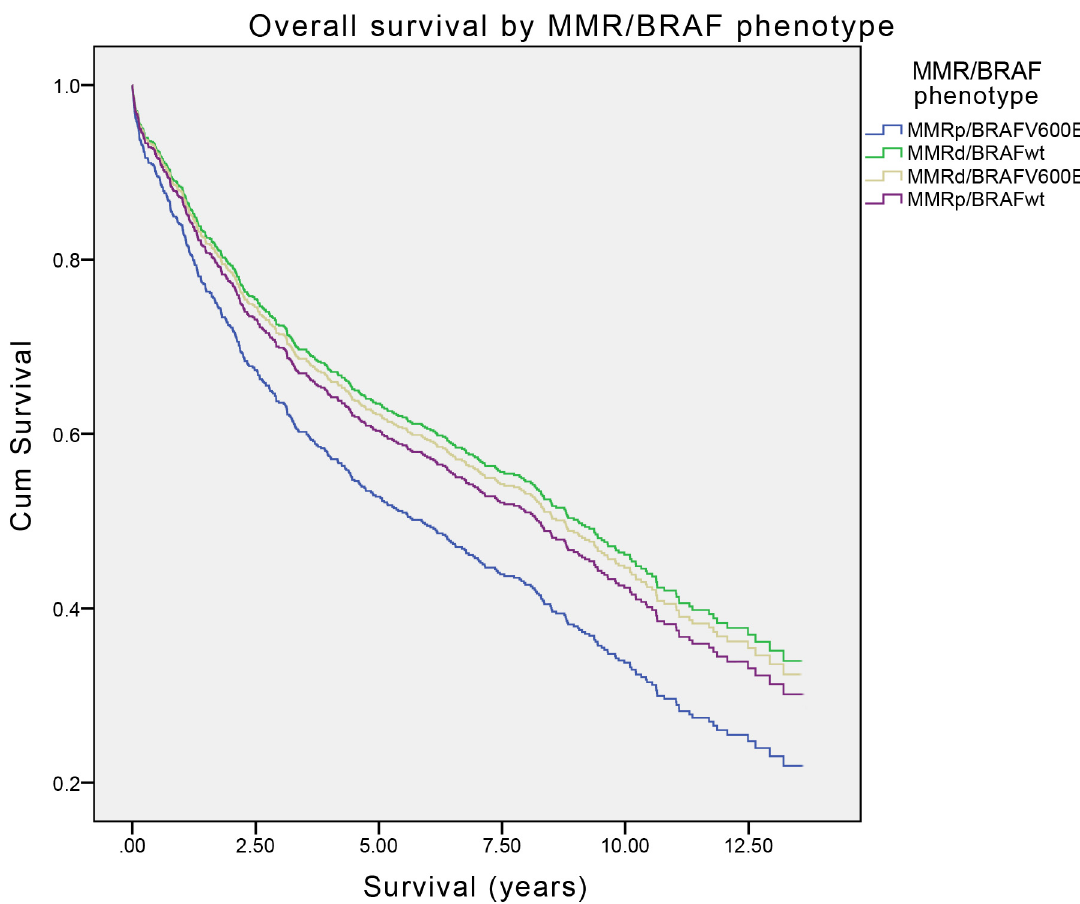
Figure 1. Overall survival of patients with CRC stratified by MMR and BRAF status (Cox regression modelling).